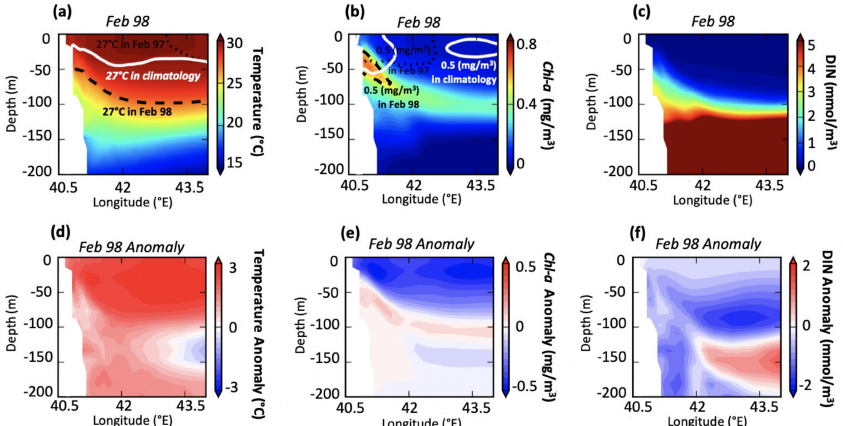
Figure 3. The subsurface signature of the NKB upwelling during February 1998 and its associated anomaly (relatively to 1998–2015 climatological period). Cross-sections of modelled ( a ) temperature in ◦ C, ( b ) Chl-a in mg / m 3 and ( c ) DIN in mmol / m 3 and ( d,e,f ) their respective anomalies are displayed along the location T1 indicated on panel ( b ) of Figure 2. The dashed black, solid white dotted black and lines on panel ( a ) represent the 27 ◦ C isotherm in February 1998, climatological February and February 1997, respectively. The dashed black, solid white dotted black and lines on panel ( b ) represent the 0.5 mg / m 3 isoline in February 1998, climatological February and February 1997,